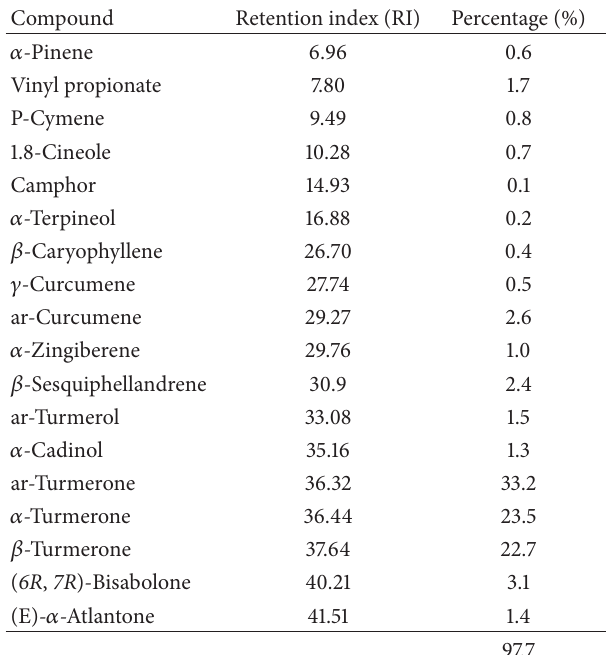
Table 1: Constituents of the essential oil from Curcuma longa L, as identified by GC/MS and